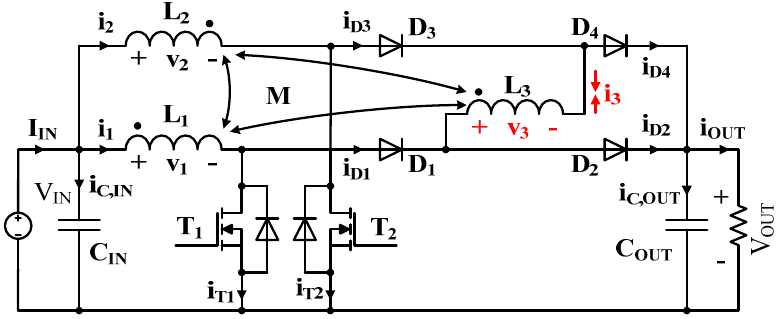
Figure 3. Proposed dual interleaved boost converter with coupled inductors and demagnetizing circuit.